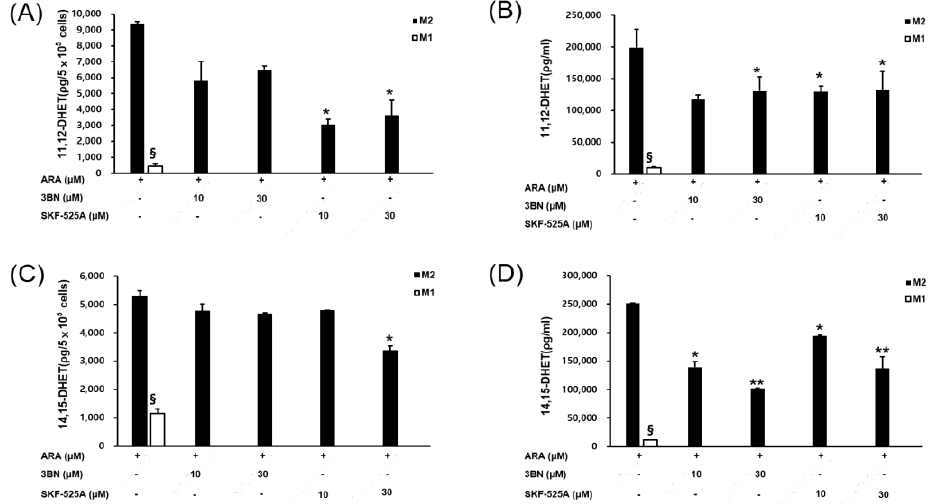
Figure 5. Influence of CYP2C19 inhibitors on 11,12-DHET and 14,15-DHET levels in M2 macrophages. The endogenous CYP2C19 metabolites 11,12-DHET and 14,15-DHET were analyzed in M2 cells treated with the CYP2C19 inhibitor 3BN and the general CYP inhibitor SKF-525A. M2 macrophages were treated with 3BN (10 and 30 µ M) and SKF-525A (10 and 30 µ M) in the presence of arachidonic acid (ARA; 100 µ M) for 24 h. The 11,12-DHET level in the cellular fraction ( A ) and media ( B ). The 14,15-DHET level in the cellular fraction ( C ) and media ( D ). Detailed methods used to determinate metabolite levels are described in the Methods and Materials. § As a control for comparison with M2 cells, M1 cells were treated with ARA in the same way as M2 cells. Since M1 cells showed very low CYP2C19 enzyme activity and metabolites were not detected after inhibitor treatment, the inhibitor 3BN treatment was omitted in M1 cells. Data are presented as the mean ± standard deviation of three independent experiments. * p < 0.05, and ** p < 0.01. *** versus the control.